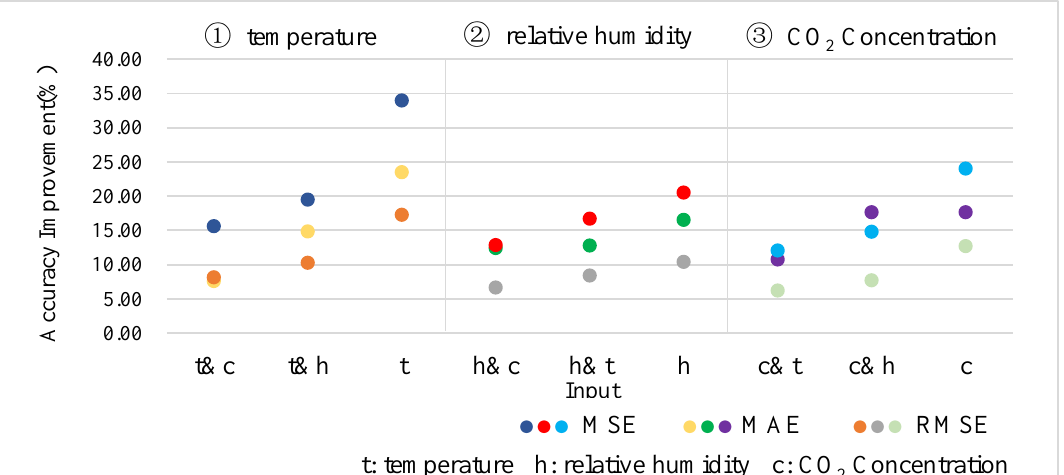
Figure 9. The prediction accuracy improvement with different input.